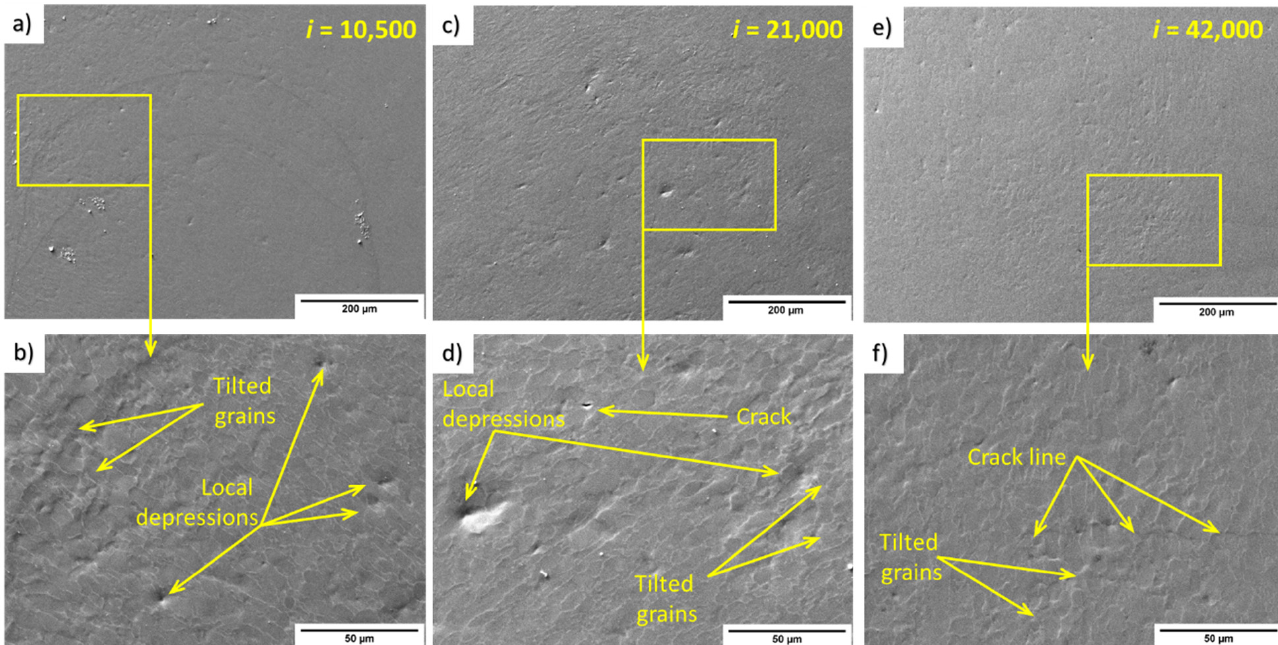
Figure 8. SEM micrographs of the surface of a Ti6Al4V sample treated by PWJ for different durations, all in SE mode: ( a ) Overview and ( b ) detail of the surface after 10,500 impacts, ( c ) Overview and ( d ) detail of the surface after 21,000 impacts, ( e ) Overview and ( f ) detail of the surface after 42,000 impacts.